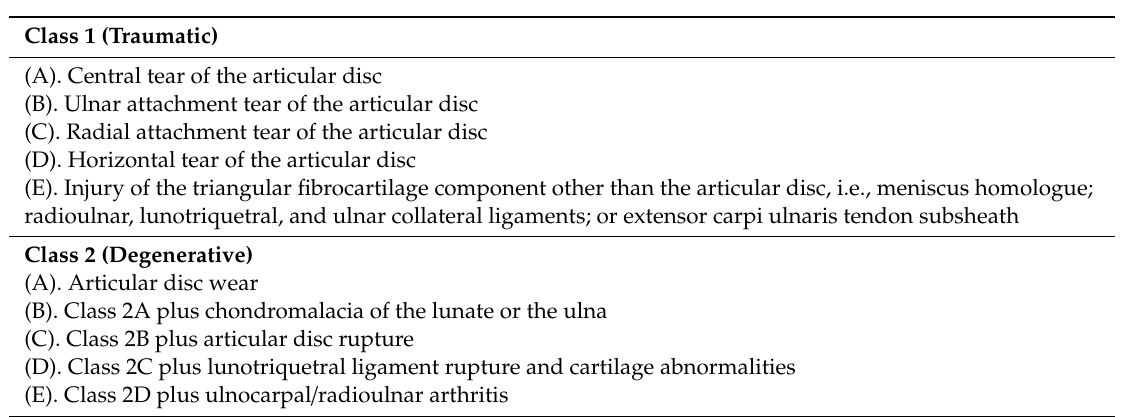
Table 1. Ultrasound classification for triangular fibrocartilage complex lesions.